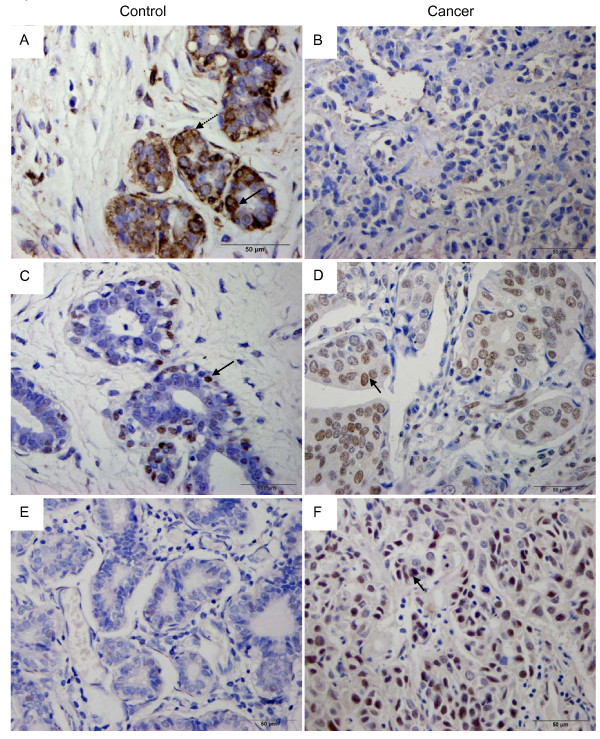
Representative photomicrographs. Immunohistochemical expressions for claudin-6, methy-CpG binding protein 2 (MeCP2) and DNA methyltransferase 1 (DNMT1) in breast invasive ductal carcinomas (IDC) and fibroadenomas (FA) (×400). (A) claudin-6 was expressed in breast adenoma cells. Note: the staining on membrane (dotted arrow); the staining in cytoplasm (solid arrow). (B) claudin-6 was weakly expressed in IDC cells. (C) MeCP2 immunoreactivity was moderate in the FA tissues (arrow). (D), (F) MeCP2 and DNMT1 were strongly expressed in breast IDC cells, especially at the nuclear (arrow). (E) DNMT1 immunoreactivity was not detected in the breast FA tissues.